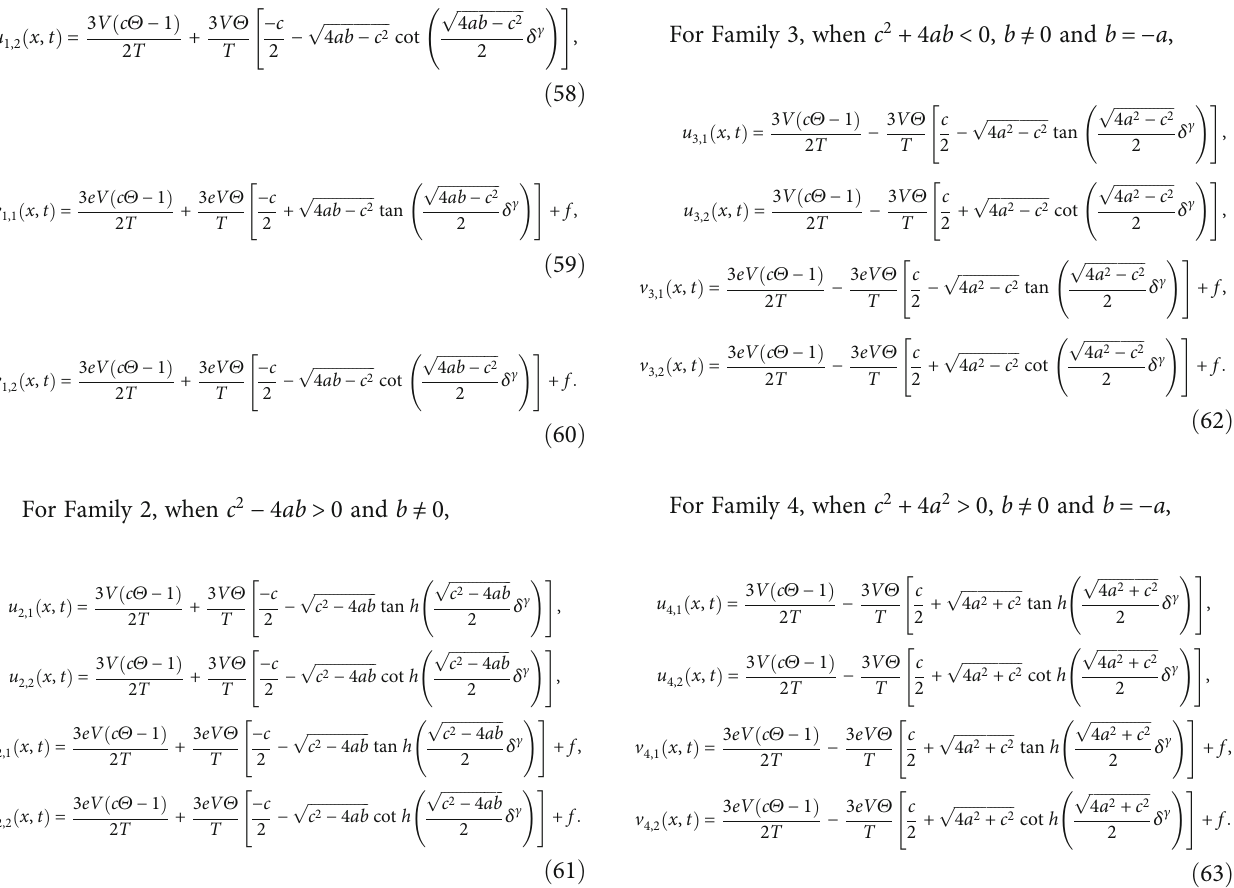
ð x , t Þ with 5,1